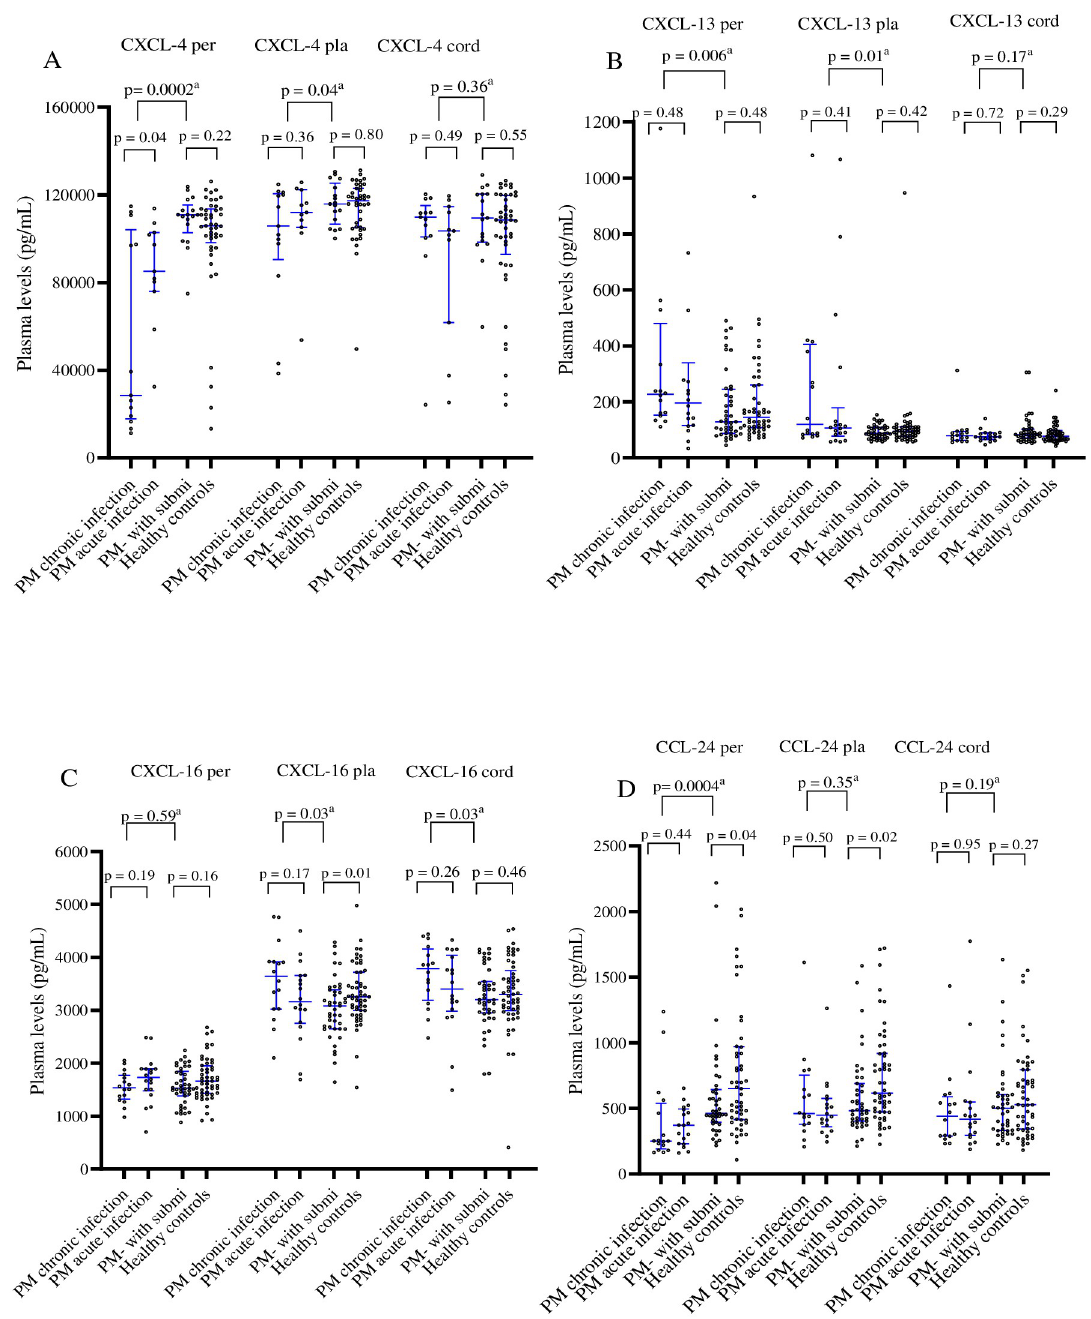
Fig 1. Plasma levels of CXCL-4, CXCL-13, CXCL-16, and CCL-24 chemokines in women at delivery in relation with placental malaria infection. The levels of different chemokines in peripheral (Per), placental (Pla), and cord plasma were compared between different groups, using Man Whitney test. a : comparison between PM+ women and PM-with submicroscopic infection; PM- with submit (PM- with submicroscopic infection): Placental malaria negative women with positive peripheral blood RT-LAMP test; PM + women: acute and chronic placental malaria positive women; Healthy controls: placental malaria negative women with negative peripheral blood RT-LAMP test.